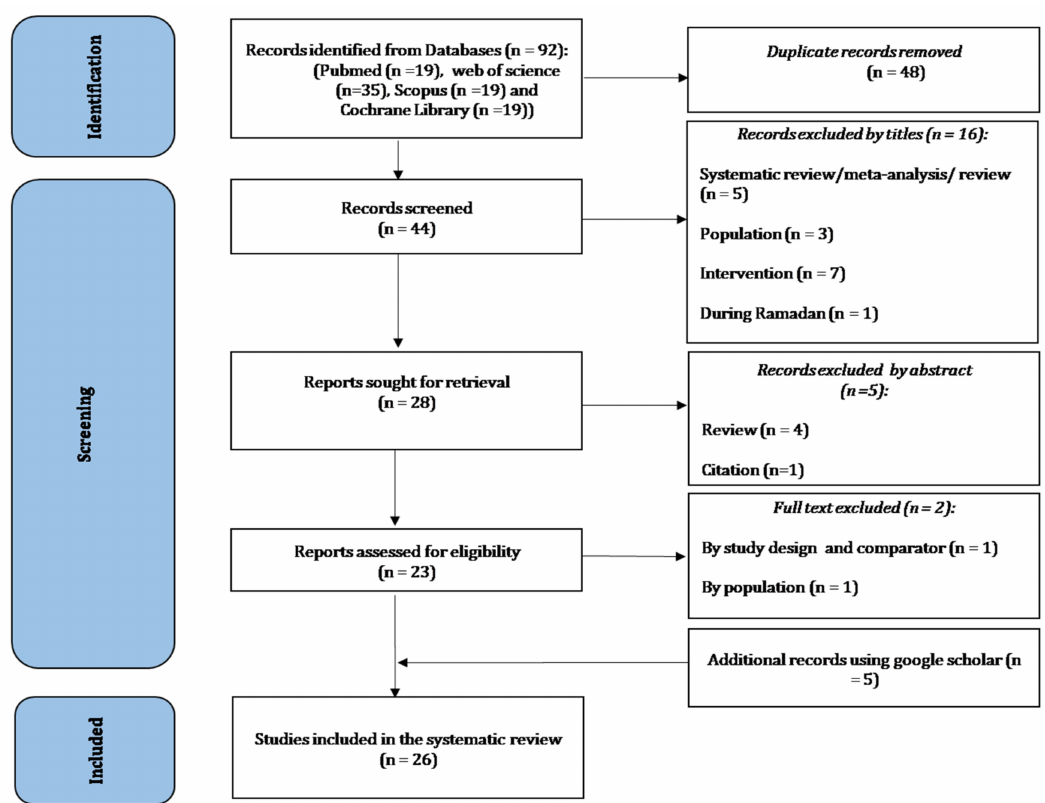
Figure 1. Flow diagram of the search